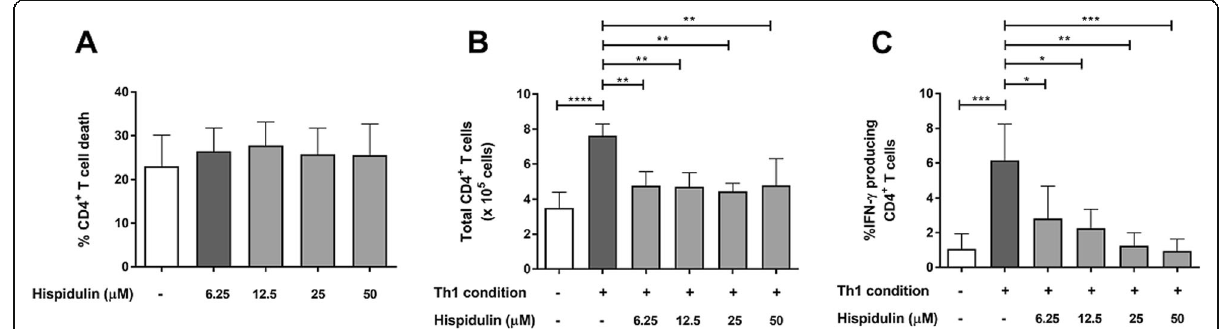
Fig. 4 Effect of hispidulin on Th1 cell differentiation. a Cytotoxicity of hispidulin. Isolated naïve CD4 + T cells were cultured with hispidulin (0 – 50 μ M) for 7days. b and c Th1 cell differentiation in the presence of hispidulin. Isolated naïve CD4 + T cells were cultured under the Th1-skewing condition in the presence of hispidulin (0 – 50 μ M). Total numbers of CD4 + T cells and percentages of IFN- γ producing CD4 + T cells were measured. All values are presented as mean±standard deviation ( n =4; * p <0.05, ** p <0.01, *** p